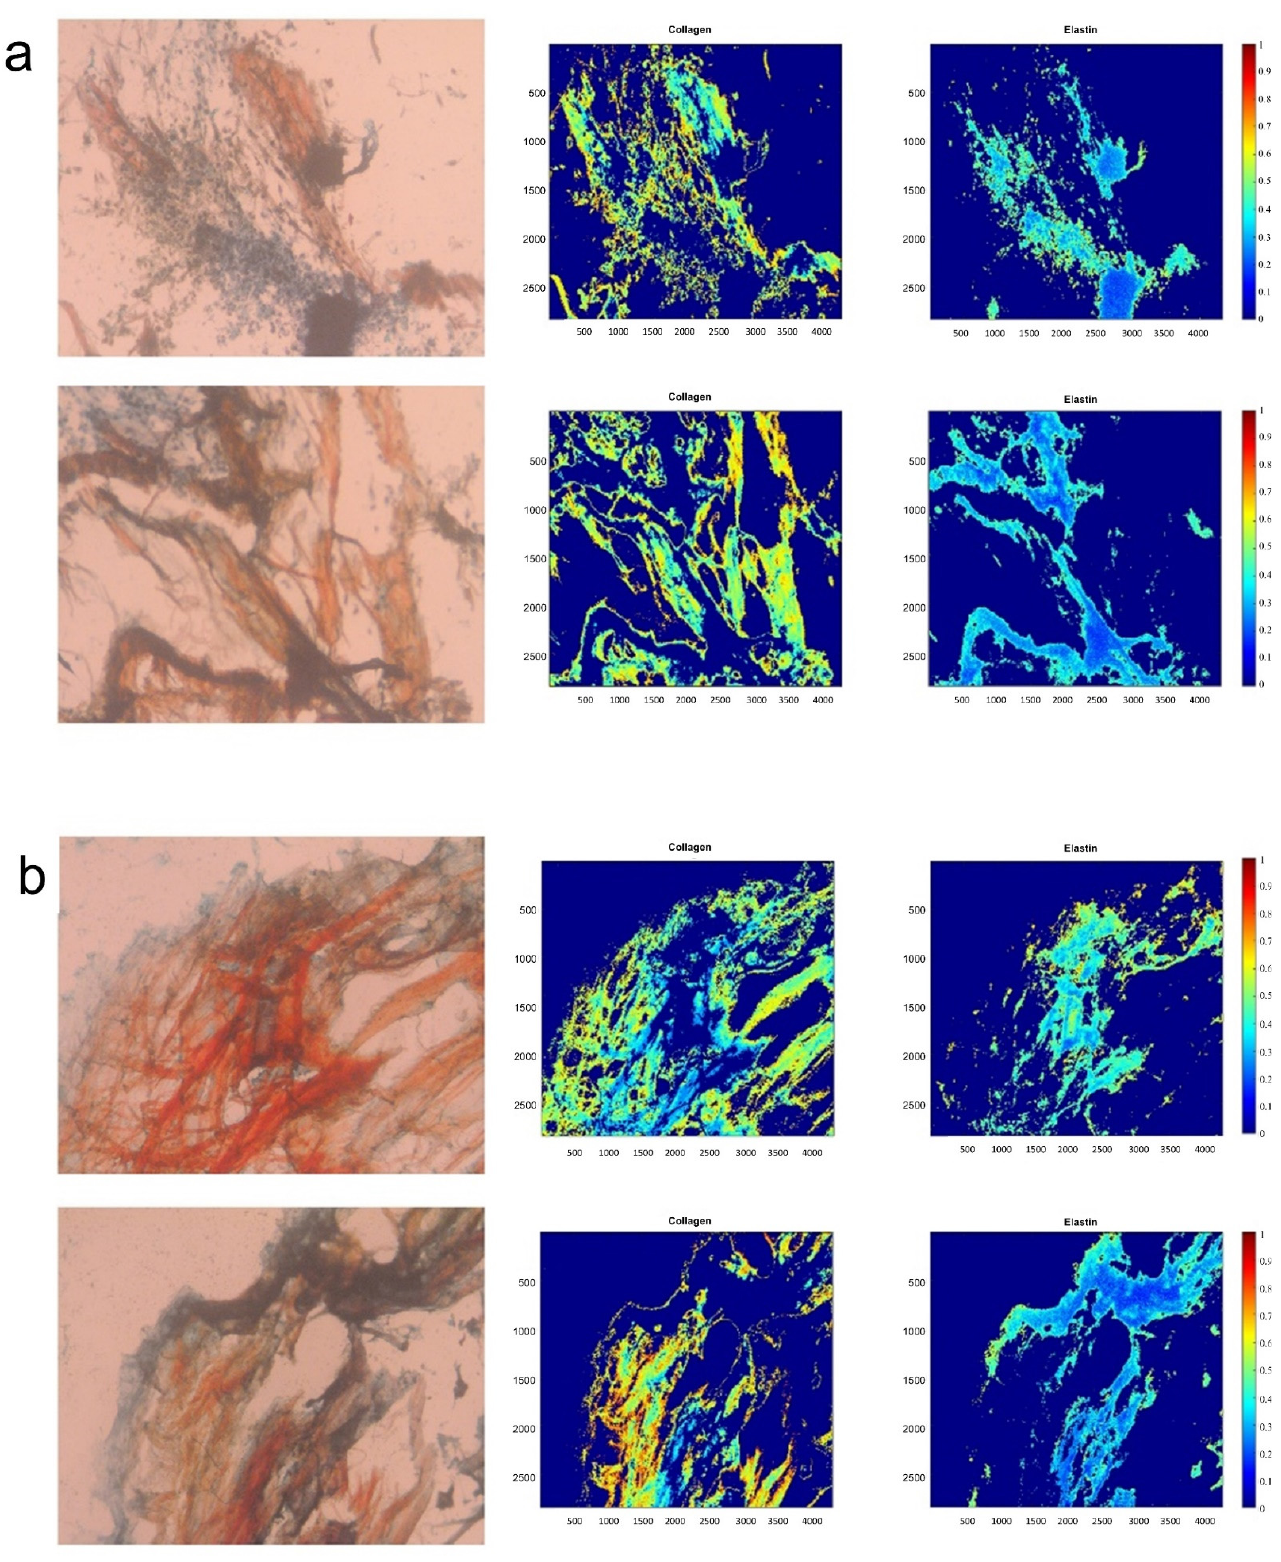
Figure 4. ECM quantification of the control (untreated) and decellularized elastin-rich engineered valve tissues. ( a ) Images of the Movat’s stained control group and ( b ) of the Movat’s stained decellularized group were assessed for quantification of ECM collagen and elastin spatial intensity maps.